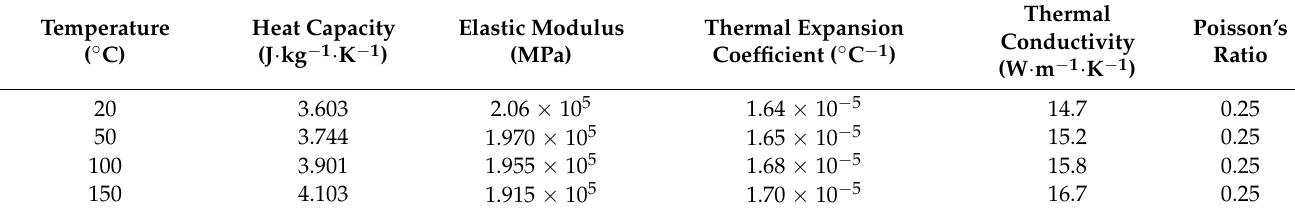
Table 1. Material model of